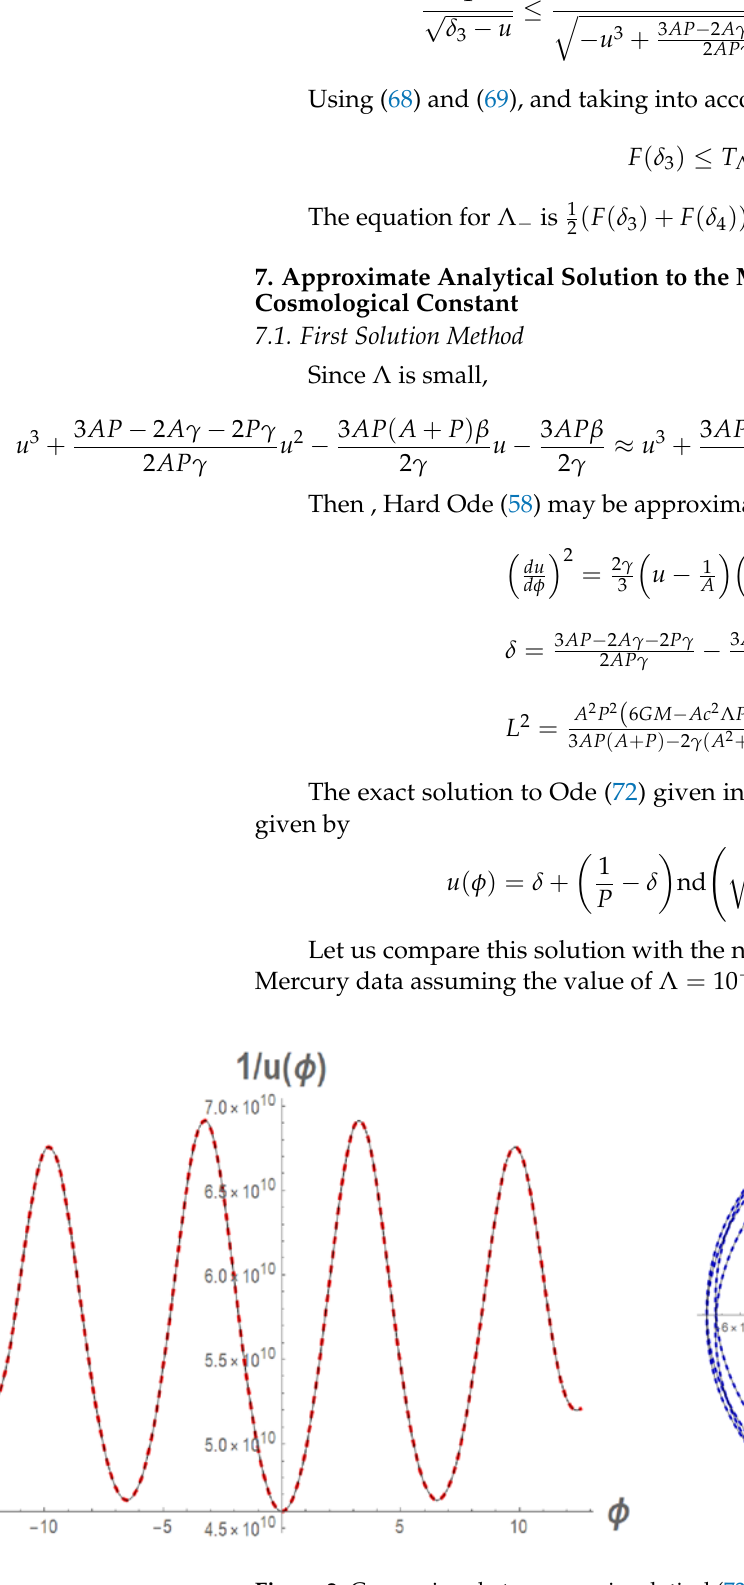
Figure 2. Comparison between semianalytical (73) and numerical solutions to the ode (28)